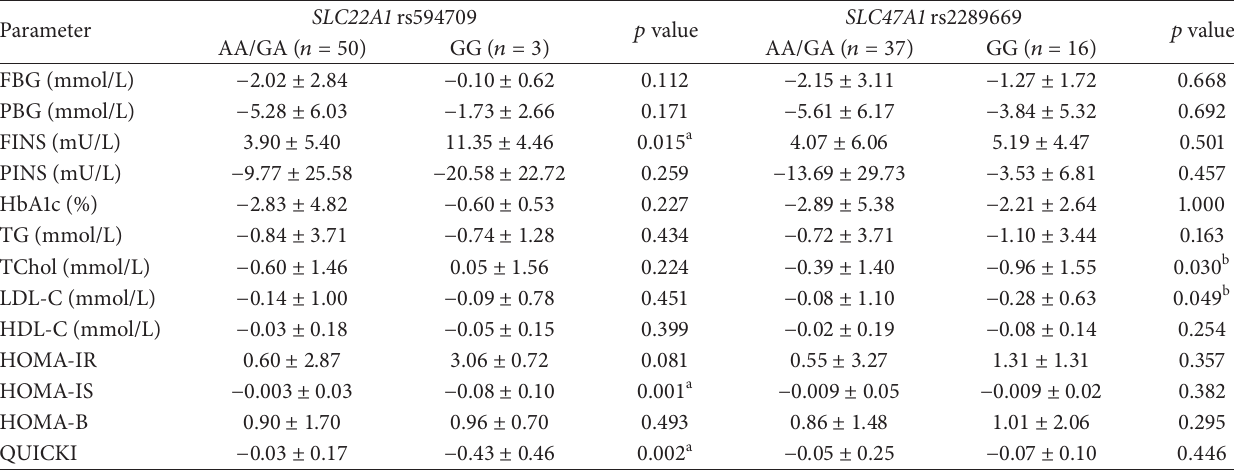
Table 3: Comparisons of differential values (post-administration minus pre-administration) in T2DM patients with different SLC22A1 rs594709 and SLC47A1 rs2289669 genotypes before and after metformin treatment.